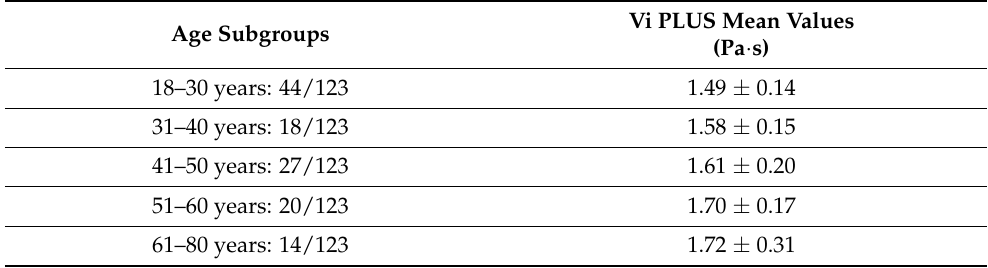
Table 2. Vi PLUS mean values according to age subgroups.